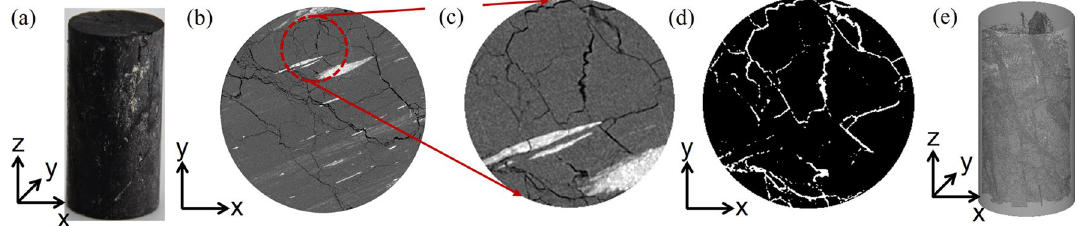
Fig. 1 Construction of digital fractured coal model. a Natural coal sample; b – d Extraction of discontinuous cracks in coal; e Digital model